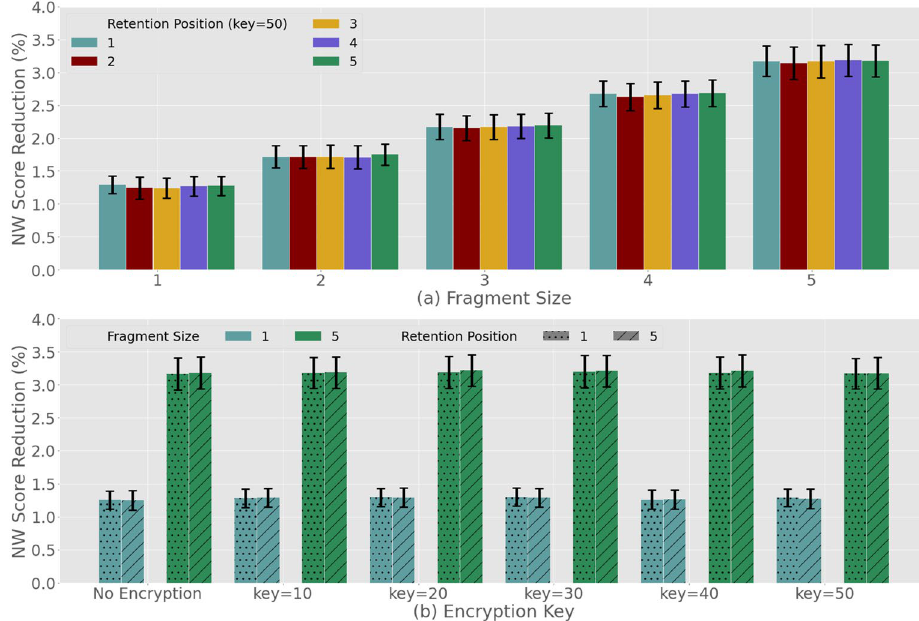
Figure 6. Trigger Sample Design, the use of DNA-Steganography: ( a ) retention of host nucleotides; ( b ) payload